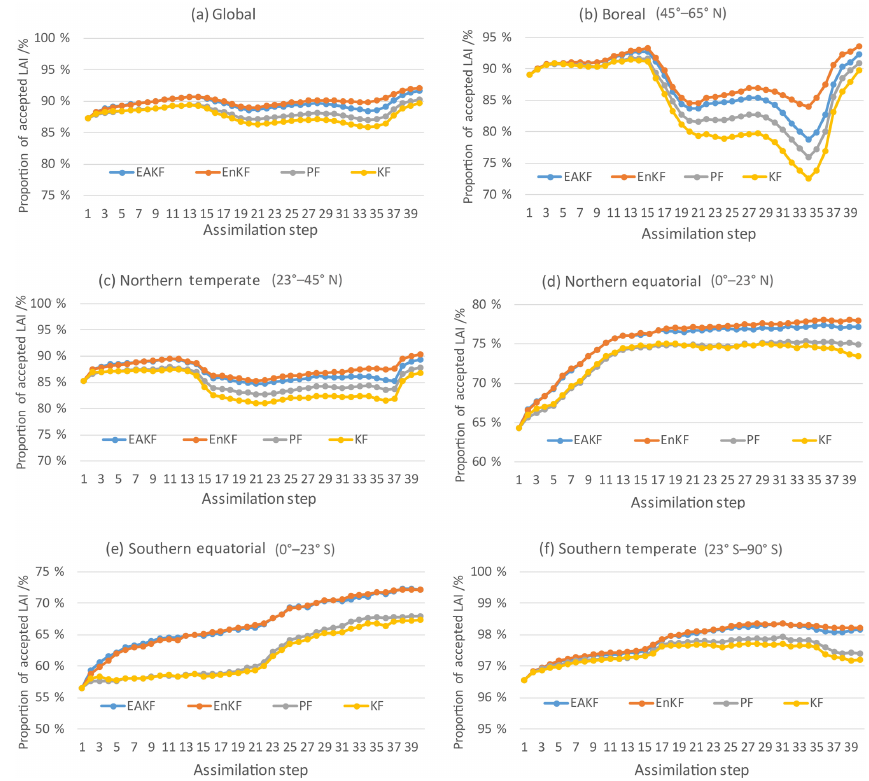
Figure 7. The proportion of accepted LAI observations for the four algorithms in the zonal